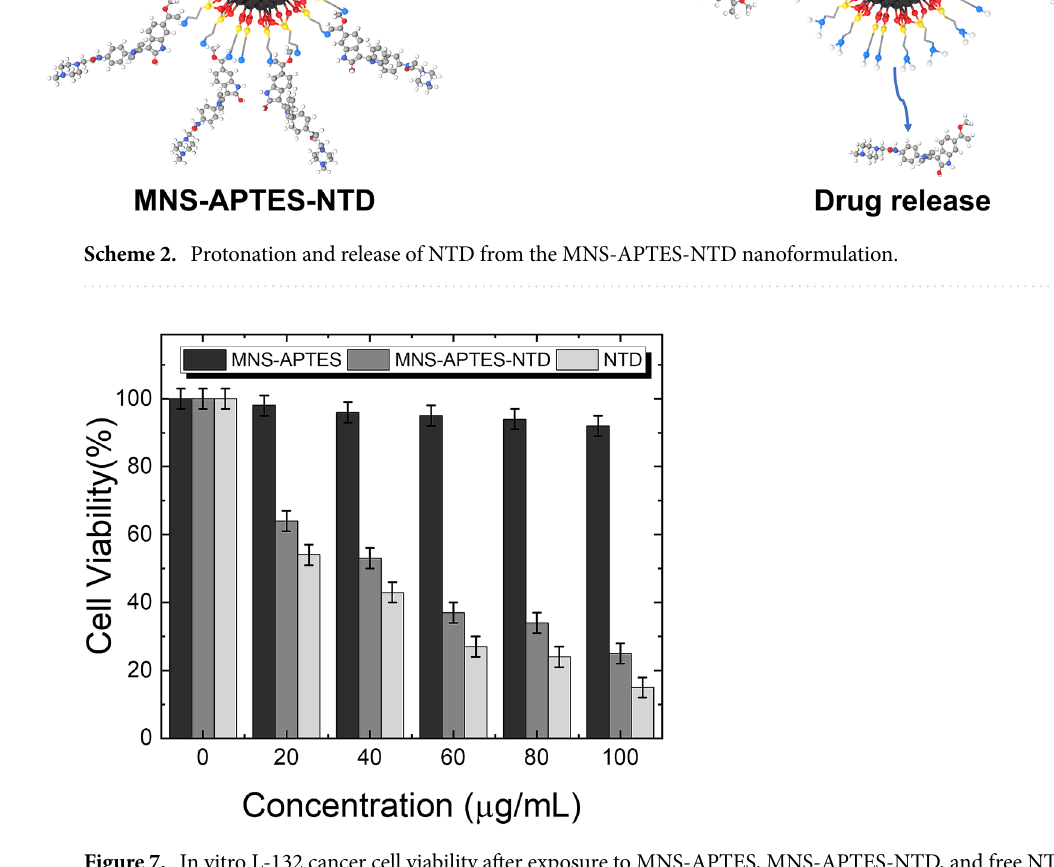
Figure 7. In vitro L-132 cancer cell viability after exposure to MNS-APTES, MNS-APTES-NTD, and free NTD at different